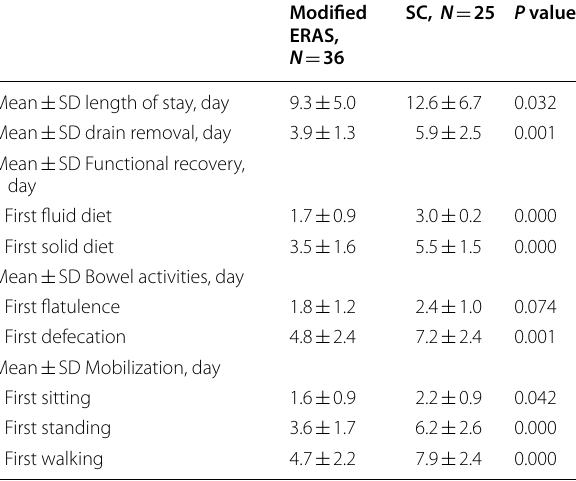
Table 3 Clinical characteristics of the samples Table 4 Postoperative milestones